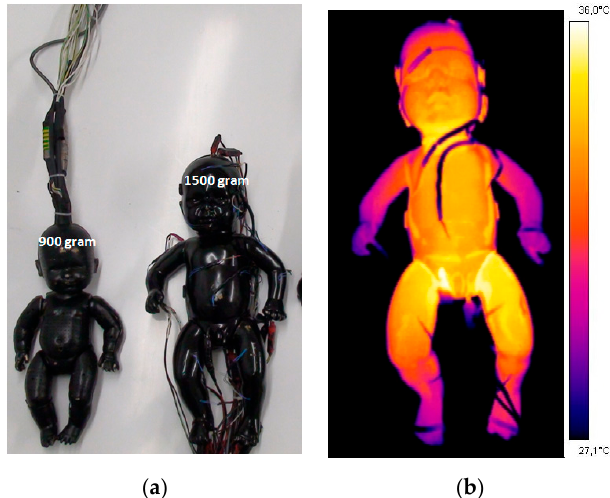
Figure 3. ( a ) Anthropomorphic, multisegment thermal mannequins representing premature neonates with simulated birth weights of 900 g (left), 1500 g (right); ( b ) the mannequin’s regional skintemperatures (recorded using infrared thermography) simulate the heterogeneity observed in neonates nursed in closed